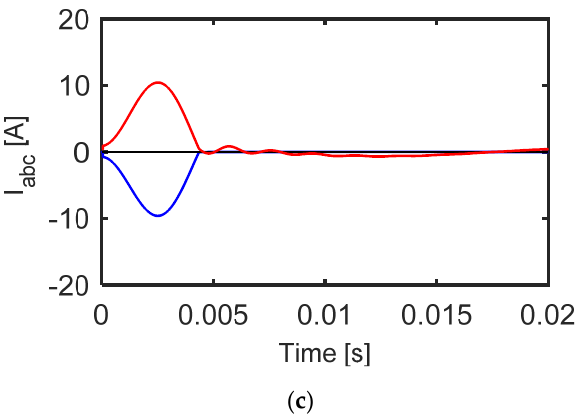
Figure 8. Simulation testing of the clamping circuit at start-up without operating the PWM of the rectifier and charging using line voltage V ab at zero crossing ( a ) Line-input voltage V ab , ( b ) DC-link voltage and ( c ) input current for MC.